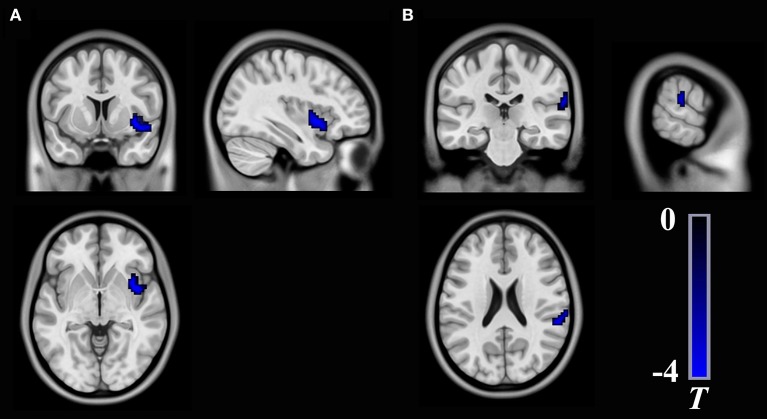
Brain regions show significant differences in long-range rsFCS (A) and short-range rsFCS (B) between T2DM patients and healthy controls. The color regions represent weaker rsFCS in patients with T2DM. The color bar indicates the T-value from two-sample t-tests. rsFCS, resting state functional connectivity strength.